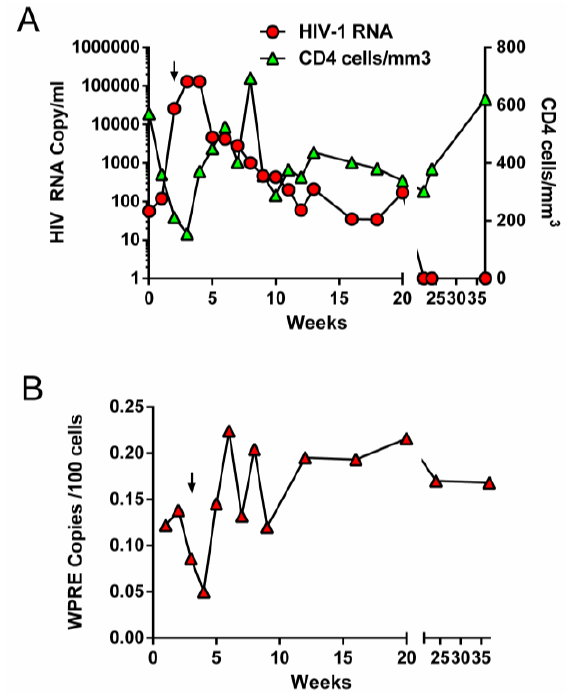
Figure 2. Monitoring of viral loads, CD4 counts and gene marking during structured treatment interruption. ( A ) HIV copies/mL of patient plasma (red circles, left Y axis) and CD4 counts/mm 3 (green triangles, right Y axis) during treatment interruption. ( B ) Gene marking expressed as copies of vector (WPRE) per 100 blood cells analyzed over time. Arrow indicates time of resumption of